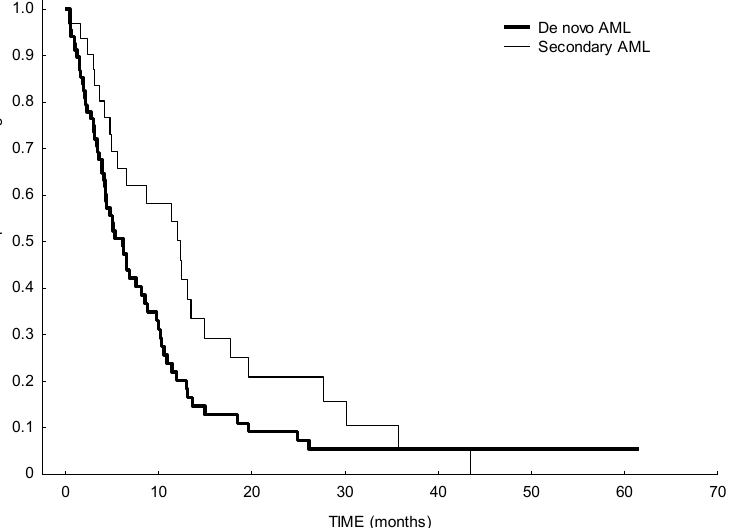
Figure 1. Survival analysis from starting of HMA in de novo versus secondary AML. Median survival in de novo AML was 6.1 months, median survival in secondary AML was 12.3 months ( p < 0.0035).